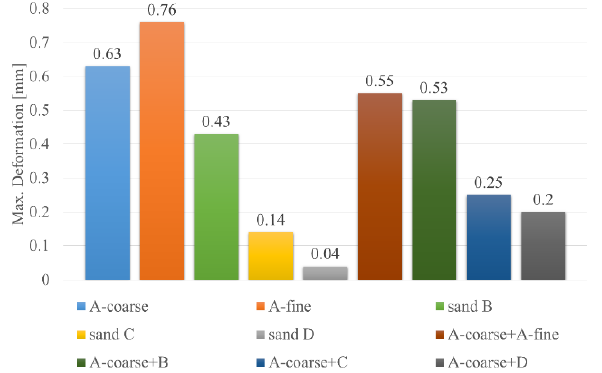
Figure 18. Hot deformation curves of specimens made of mixing sands in a 50:50 ratio: ( a ) general view, ( b ) detail.